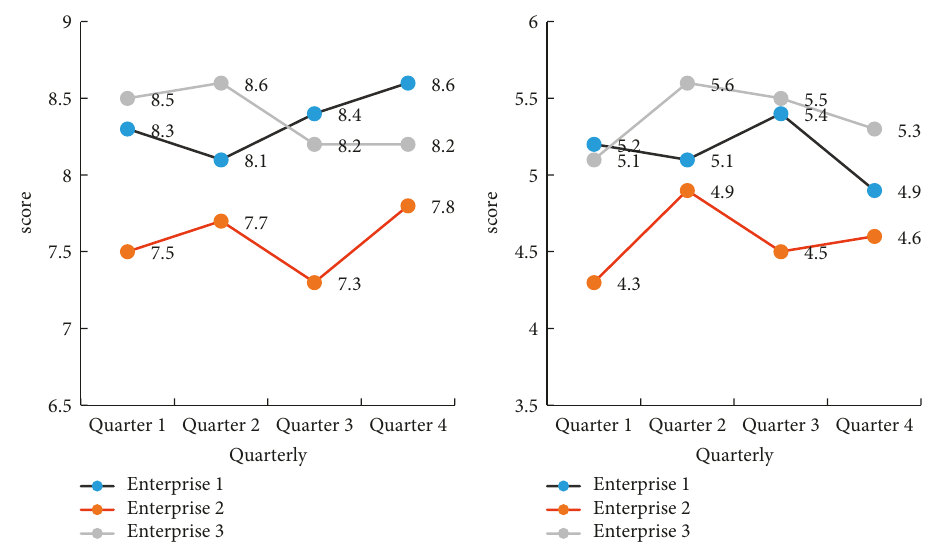
Figure 10: Comparison of company risk value scores before and after management